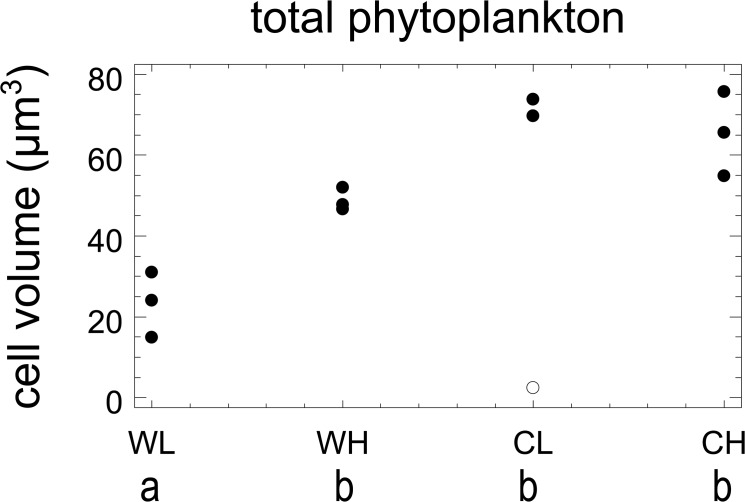
Community mean cell size.Response of community mean cell size (calculated from mean total biovolumes divided by mean cell numbers for each mesocosm) to the experimental treatments, mesocosm 9 shown by an open symbol. Treatment codes: WL: warm, low CO2, WH: warm, high CO2, CL: cold, low CO2, CH: cold, high CO2; codes for homogenous groups according to Tukey’s HSD: a, b.